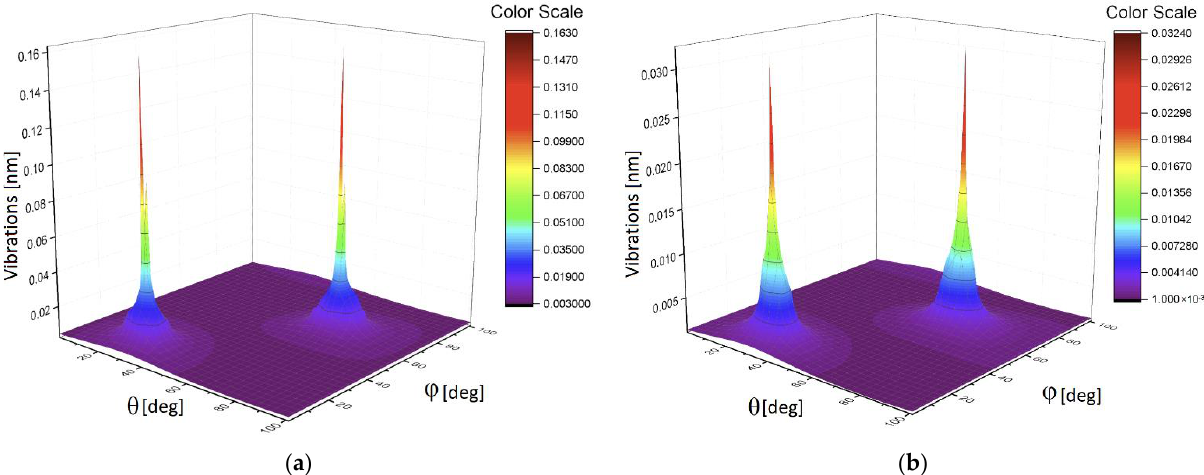
Figure 11. ( a ) The 3D surface for the L = 90 g; ( b ) the 3D surface for L = 100